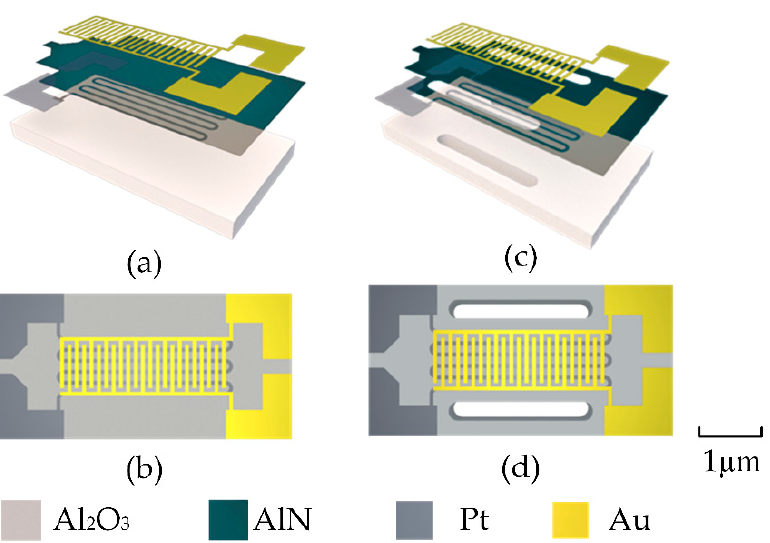
Figure 2. ( a ) Decomposition of the second design, which has an alumina ceramic-based AlN film as the insulating thermal conductivity layer. ( b ) Main view of the second design. ( c ) Decomposition of the third design with the addition of thermal insulation holes. ( d ) Main view of the third design.